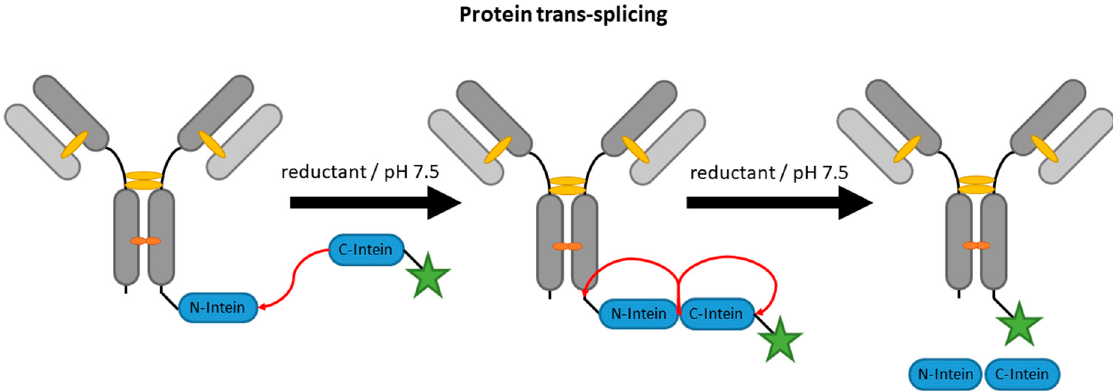
Figure 6. Scheme of an antibody modification by trans-splicing.